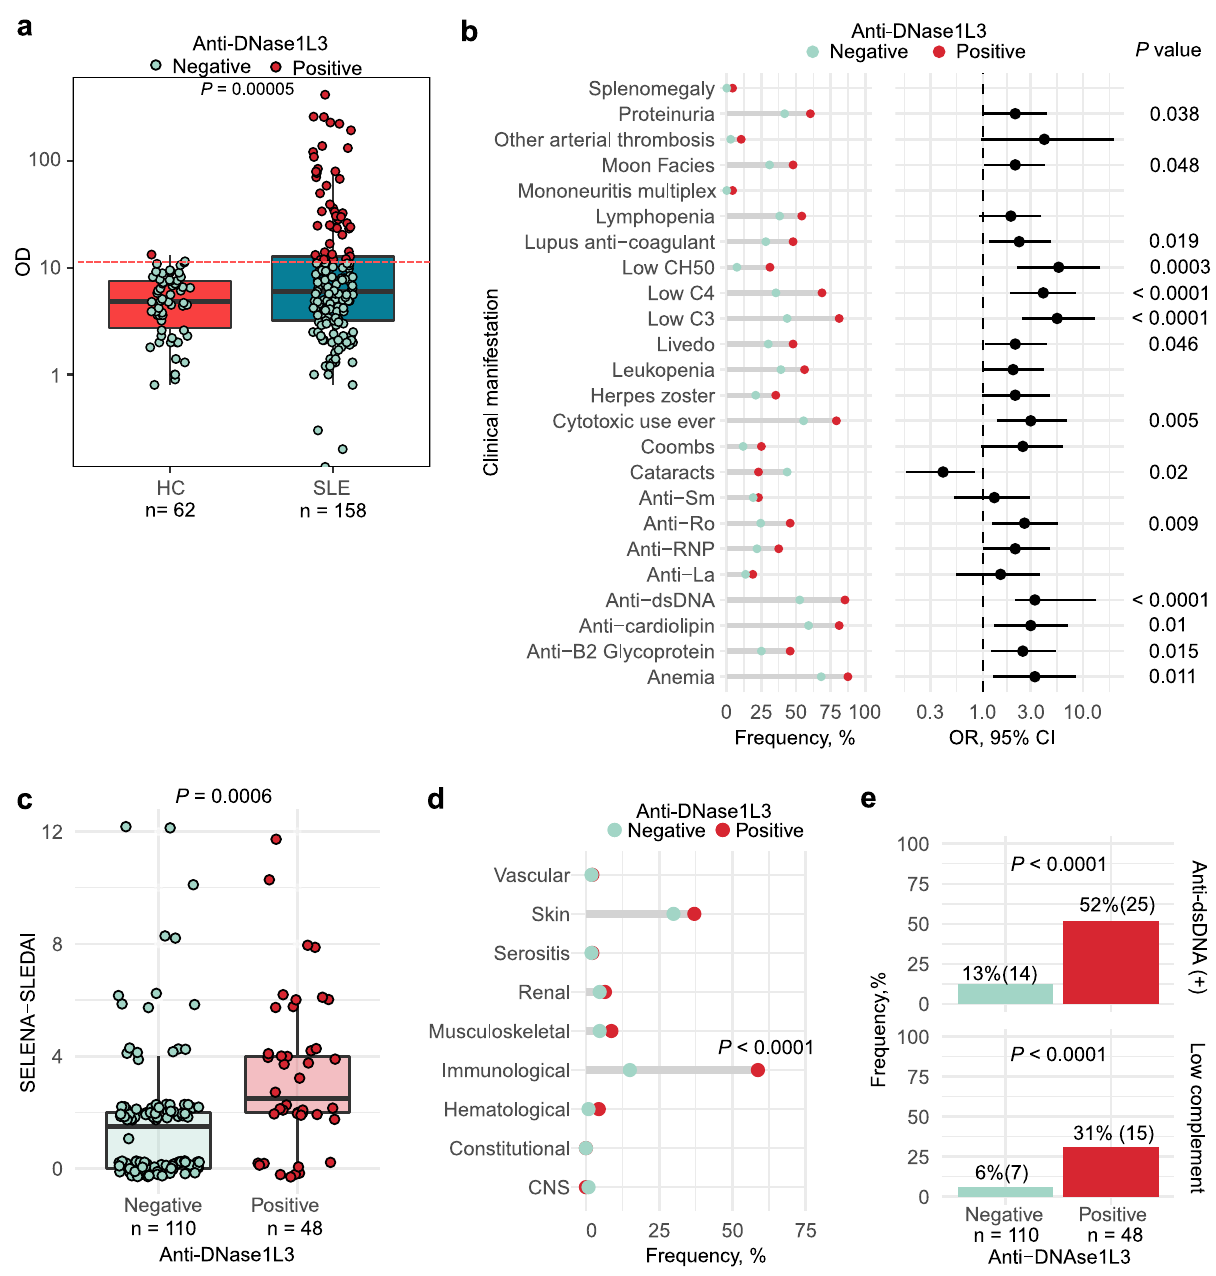
Fig.1|Prevalence,clinicalandserologicassociationsofantibodiestoDNase1L3 in a prospective observational cohort of patients with SLE. a Serum levels and positivity of anti-DNase1L3 antibodies in healthy controls (HC) and patients with SLE. Using a cutoff of two standard deviations above the mean anti-DNase1L3 antibody level in healthy sera, 1.6% (1/62) of healthy controls and 30% (48/158) of SLE patients were positive for anti-DNase1L3 antibodies. b Associations between anti-DNase1L3 antibodies and clinical/serologic features in SLE. Bars represent the frequencyofclinical/serologicfeaturesaccordingtoanti-DNase1L3antibodystatus (left)andtheircorrespondingORwith95%CI(right). c SafetyofEstrogensinLupus